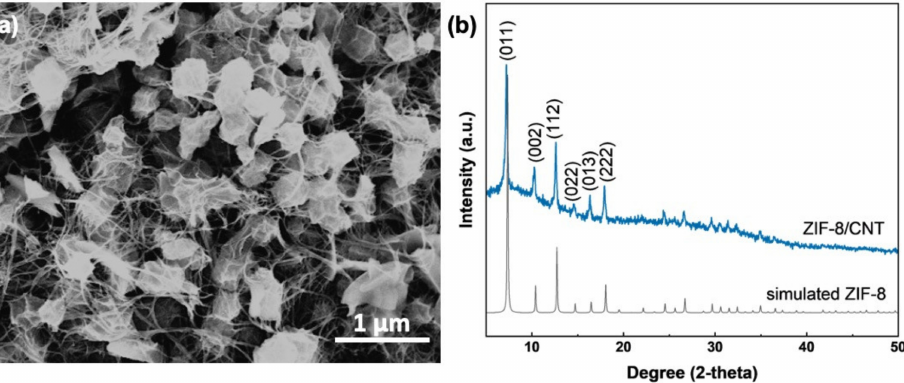
Figure 1. ZIF-8/CNT composite: ( a ) SEM image; ( b ) XRD pattern compared to that of simulated